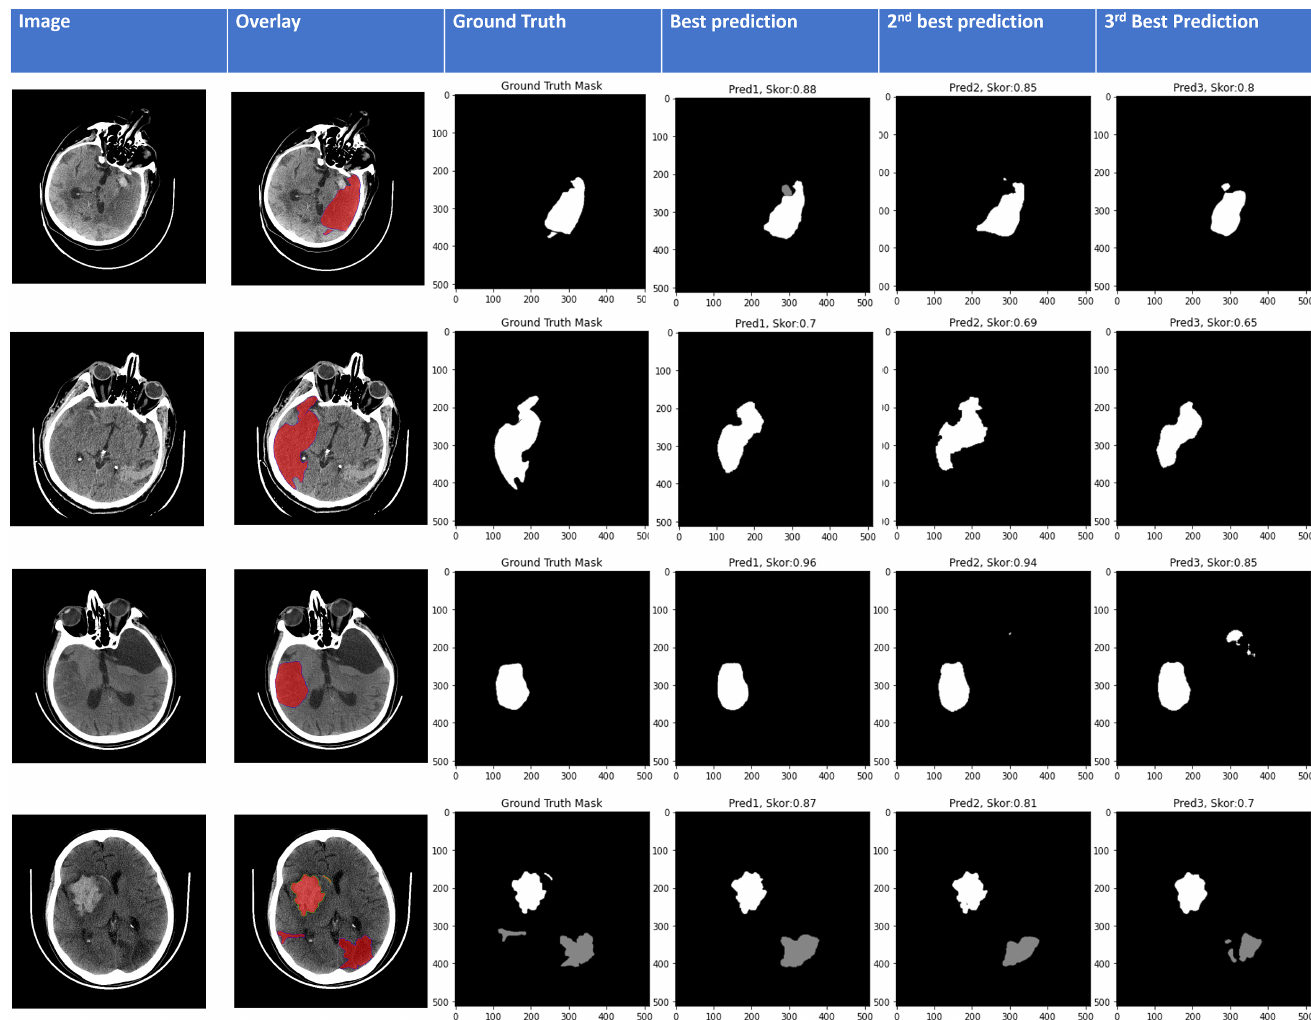
Figure 6. Top 3 IoU scores for 4 images (misleading images). First row CT image consisted of both ischemic core and aneurysm ipsilaterally, second row CT image had both ischemic core and vascular anomaly contralaterally, third row CT image had arachnoid cyst and ischemic core contralaterally, and fourth row CT image had both ischemic cores and hemorrhagic areas. CT, computed